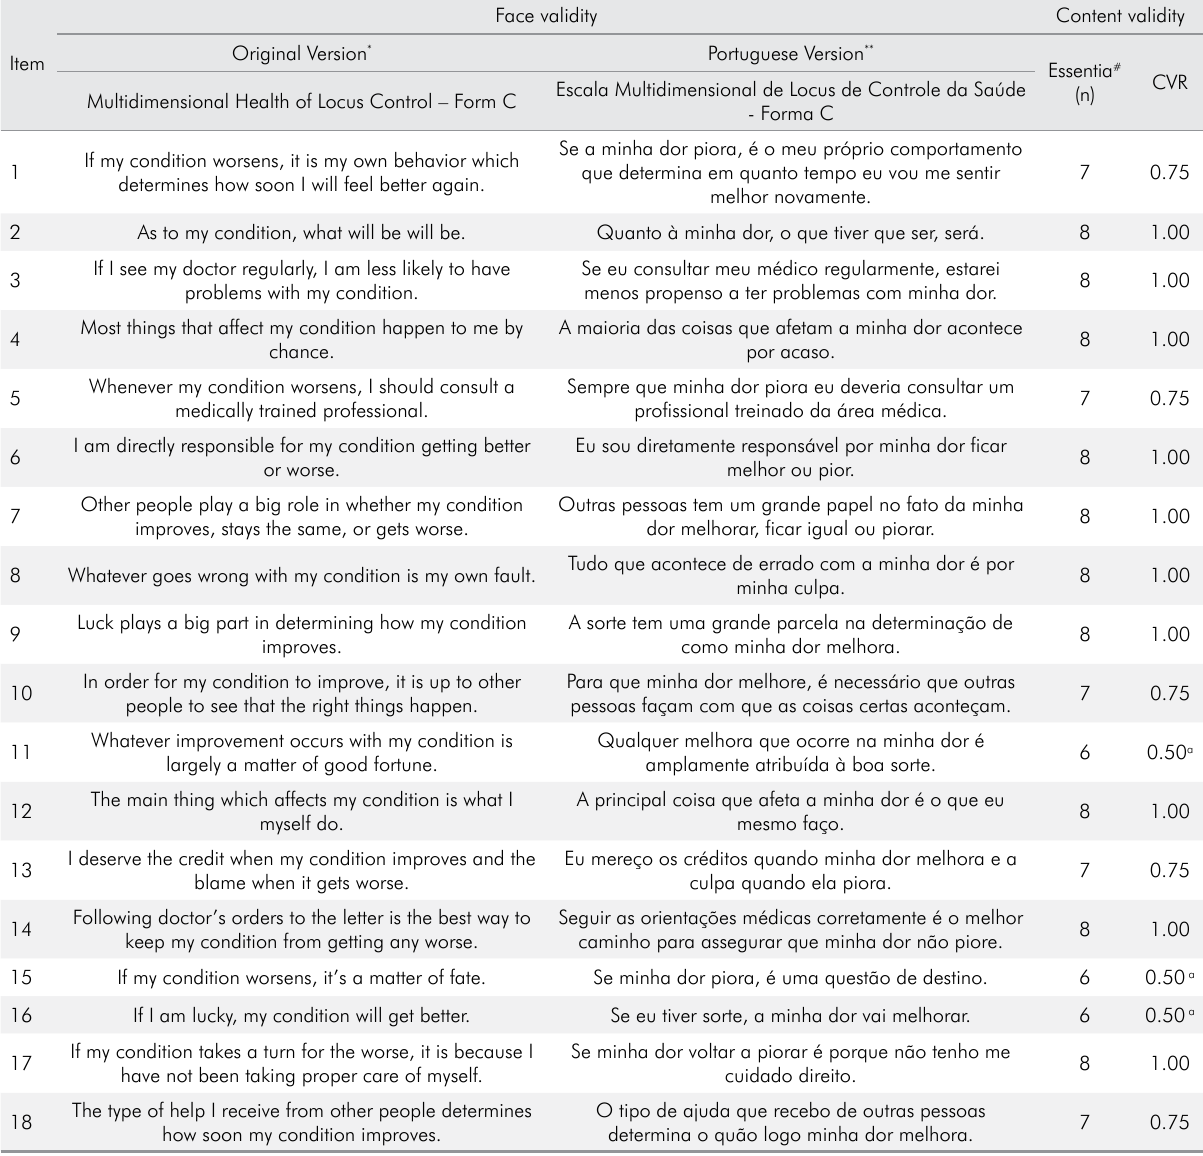
Table 2. Original version, Portuguese version, and content validity ratio (CVR) of the Multidimensional Health Locus of Control – Form C (MHLC-C)